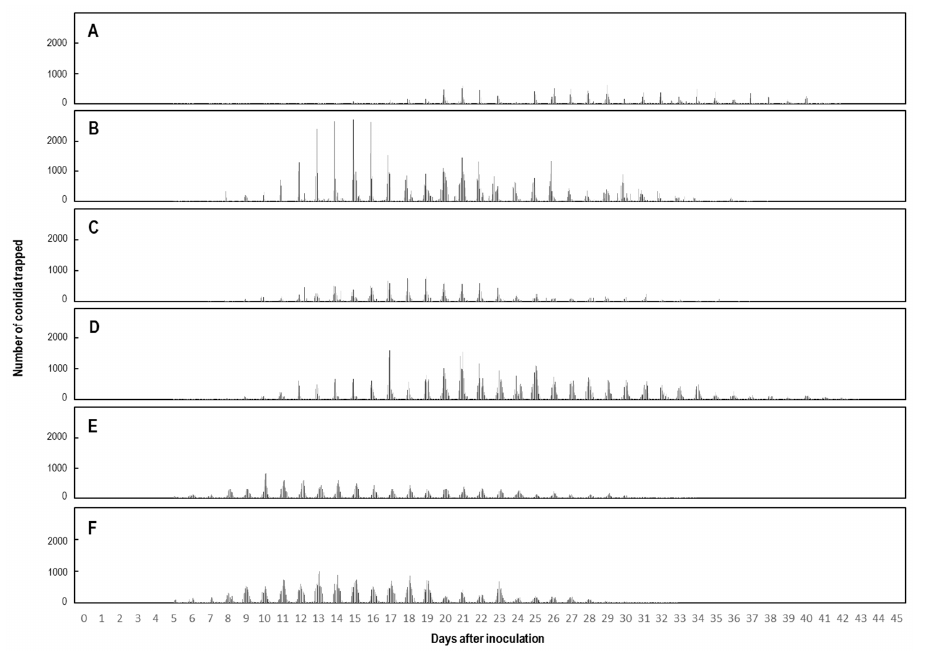
Figure 2. Lifelong production of asexual conidia released from single KSP-7N colonies was assessed from total number of progeny conidia collected in 1 h. Progeny conidia from single KSP-7N colonies on leaves of living strawberry seedlings were trapped using an electrostatic rotational spore collector (insulator drum) in February ( A ), May ( B ), July ( C ), October ( D ), November ( E ), and December ( F ) in 2021. In each panel, ( A – F ) was recorded 45 days, which is more than 1 month.